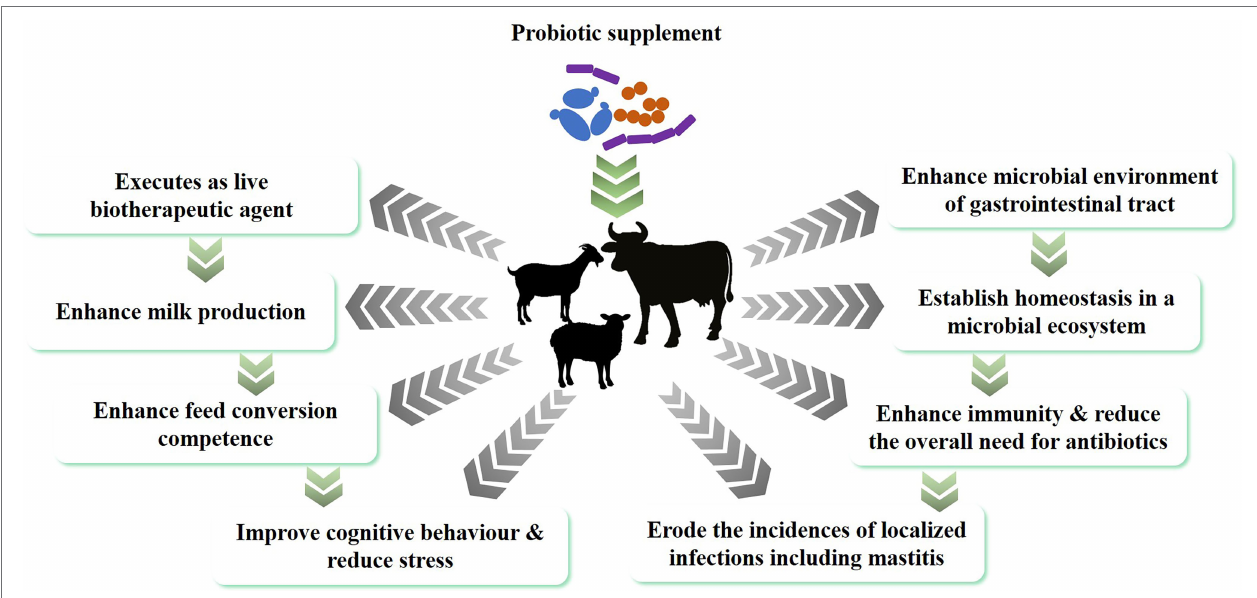
FIGURE 1 | Impact of probiotics on the general health of dairy